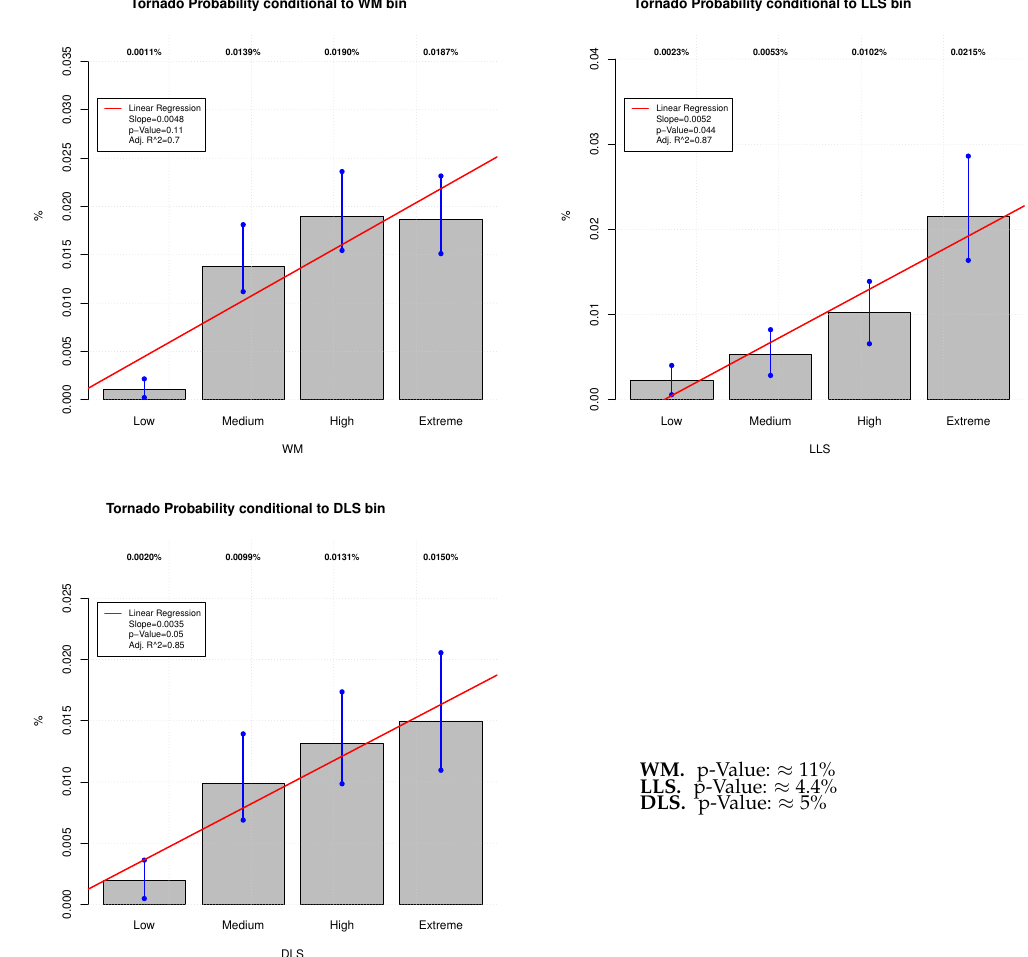
Figure 5. Estimates (bars) of the probability of tornado occurrence conditional to the fact that WM ( top-left ), or LLS ( top-right ), or DLS ( bottom-left ) takes on a value in a given bin at TS1 (ERA-5 dataset). The vertical blue lines correspond to 95% bootstrap Confidence Intervals. The red lines represent the outcome of the linear regression, and the legends report the main statistical results. The top labels show the conditional probabilities in each bin (% value). The bottom-right panel summarizes and compares the regression p